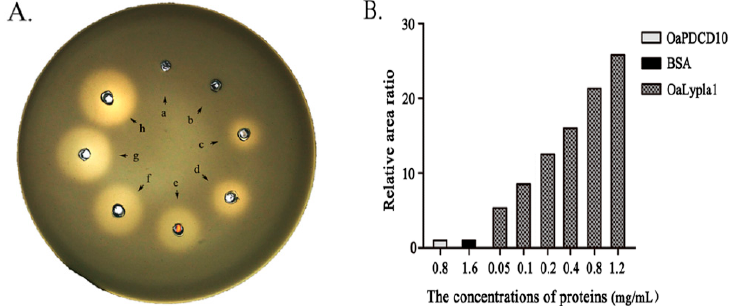
Figure 5. Phospholipase activity assay of the OaLypla1 protein. ( A ) Egg yolk/agarose diffusion test: a, 0.8 mg/mL OaPDCD10 with a His 6 -tag; b, 1.6 mg/mL BSA; and c–h, 0.05, 0.1, 0.2, 0.4, 0.8 and 1.2 mg/mL of OaLypla1H; ( B ) Relative area ratio. The results were calculated as a measure of the relative area ratio with the area of the hole in the center as 100%.